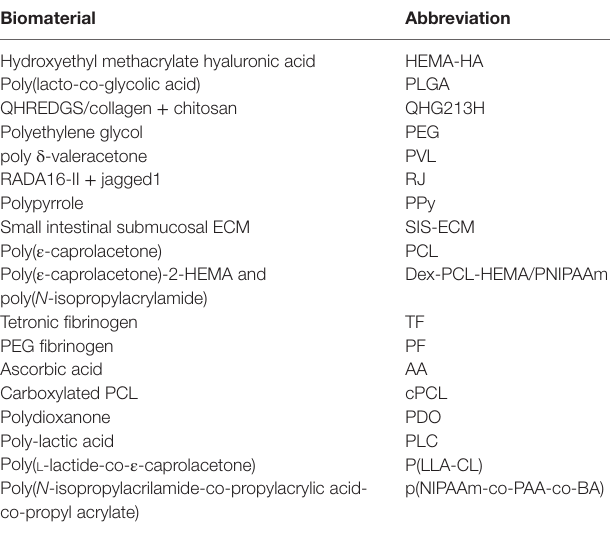
TABLe 1 | List of material